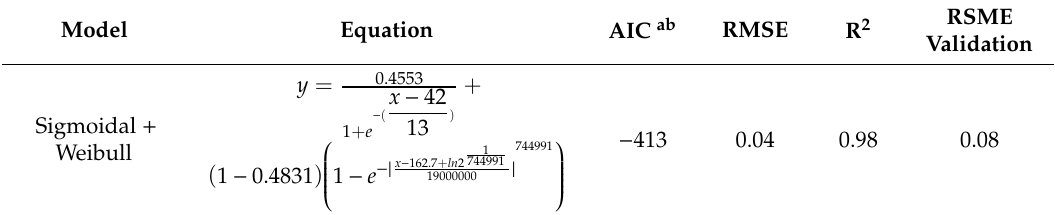
Table 3. Predictive model of R. raphanistrum emergence fit to relative cumulative pixels over time. Predicted values were regressed with observed pixel values used to create the model (RMSE and R 2 ) and for validation, with relative cumulative emergence of true counts (RMSE